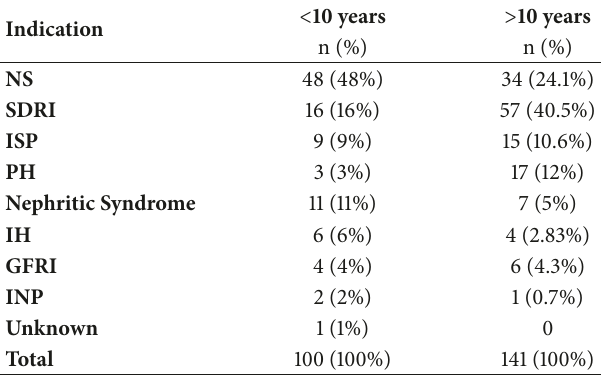
Table 3: Indications frequency according to age.